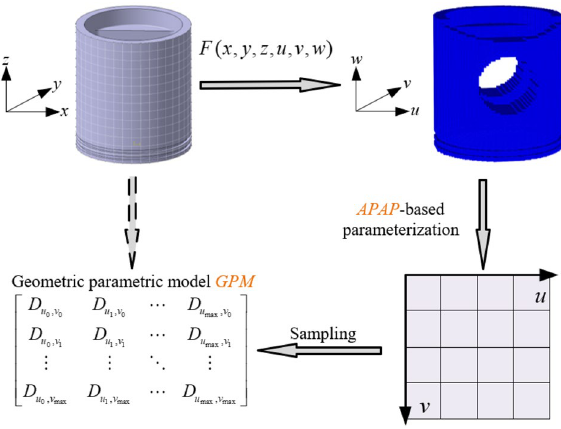
Figure 4. Geometry model